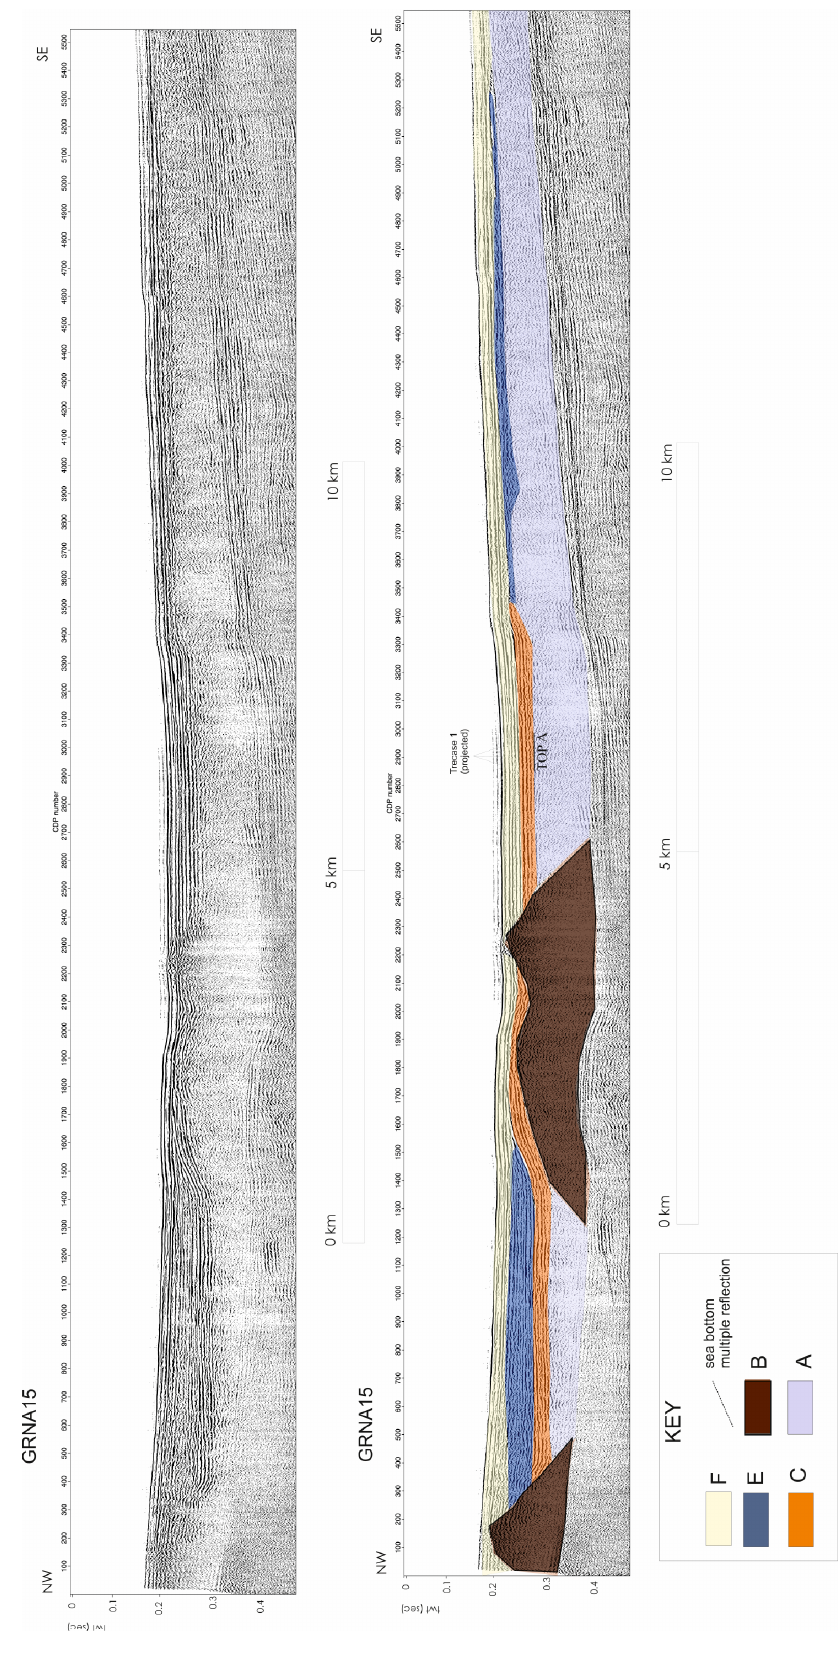
Figure 8. Seismic profile Grna15 and corresponding geologic interpretation, calibrated with the “Trecase 1” well (Figure 2).